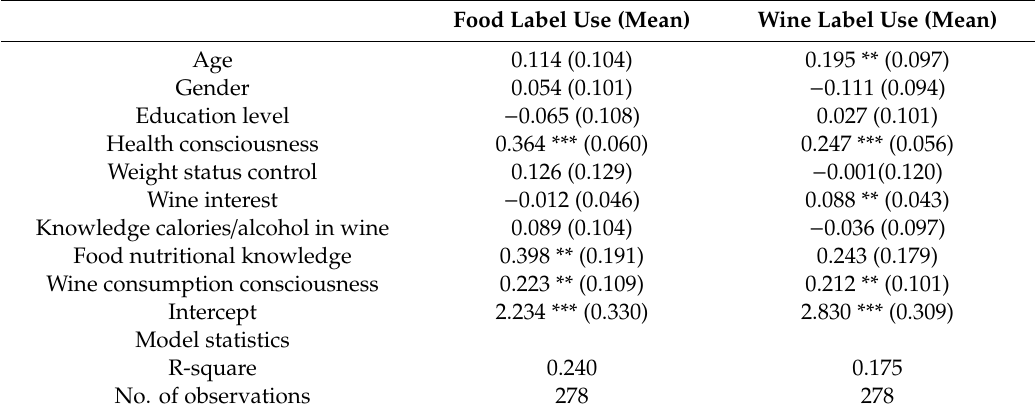
Table 4. Ordinary Least Square regression model results concerning reading food and wine labels. Food Label Use